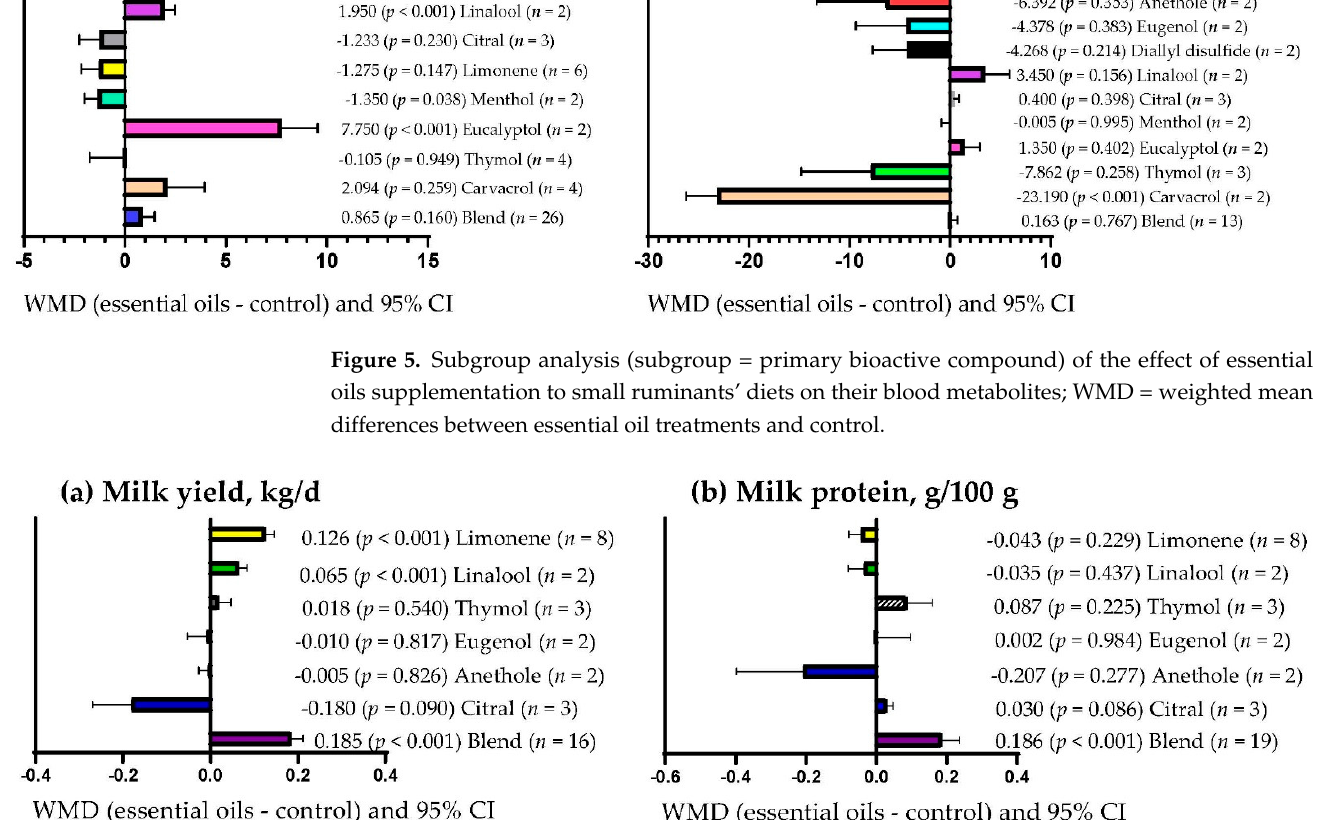
Figure 6. Subgroup analysis (subgroup = primary bioactive compound) of the effect of essential oils supplementation to small ruminants’ diets on their milk yield and composition; WMD = weighted mean differences between essential oil treatments and control.